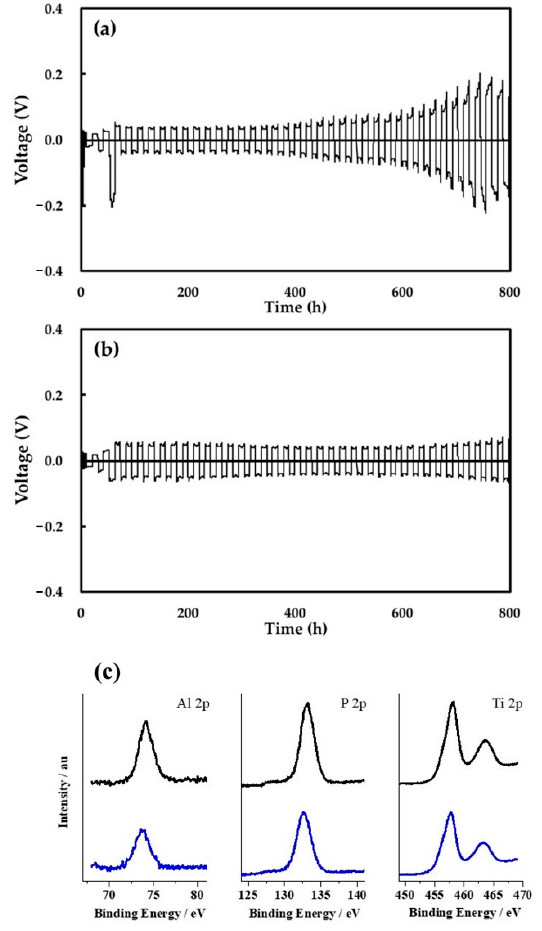
Figure 5. ( a , b ) Cycling performance of the Li deposition/dissolution process for the Li/Li symmetric cells using ( a ) the PE separator and ( b ) the LICGC/PEO/LiTFSI-PE separator. ( c ) XPS analysis of the LICGC/PEO/LiTFSI-coated PE separator before (black) and after (blue) 10 cycles of Li deposi- tion/dissolution reaction.